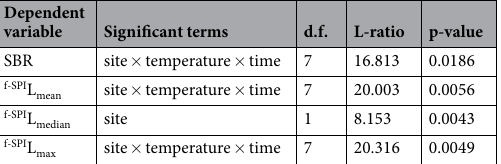
Table 4. Summary of significant terms from the GLS for particle reworking measurements, with bioturbation components as dependent variables and site, treatment and time as explanatory